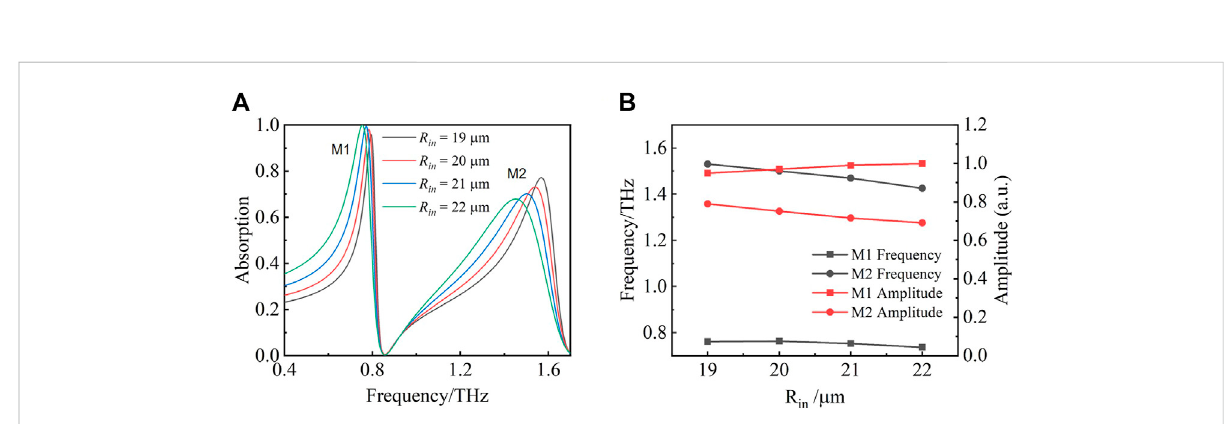
FIGURE 6 (A) The graph of the absorption lines corresponding to R in from 19 to 22 µm . (B) Line graph of maximum absorption and resonant frequency of the absorption corresponding to R in from 19 to 22 µm